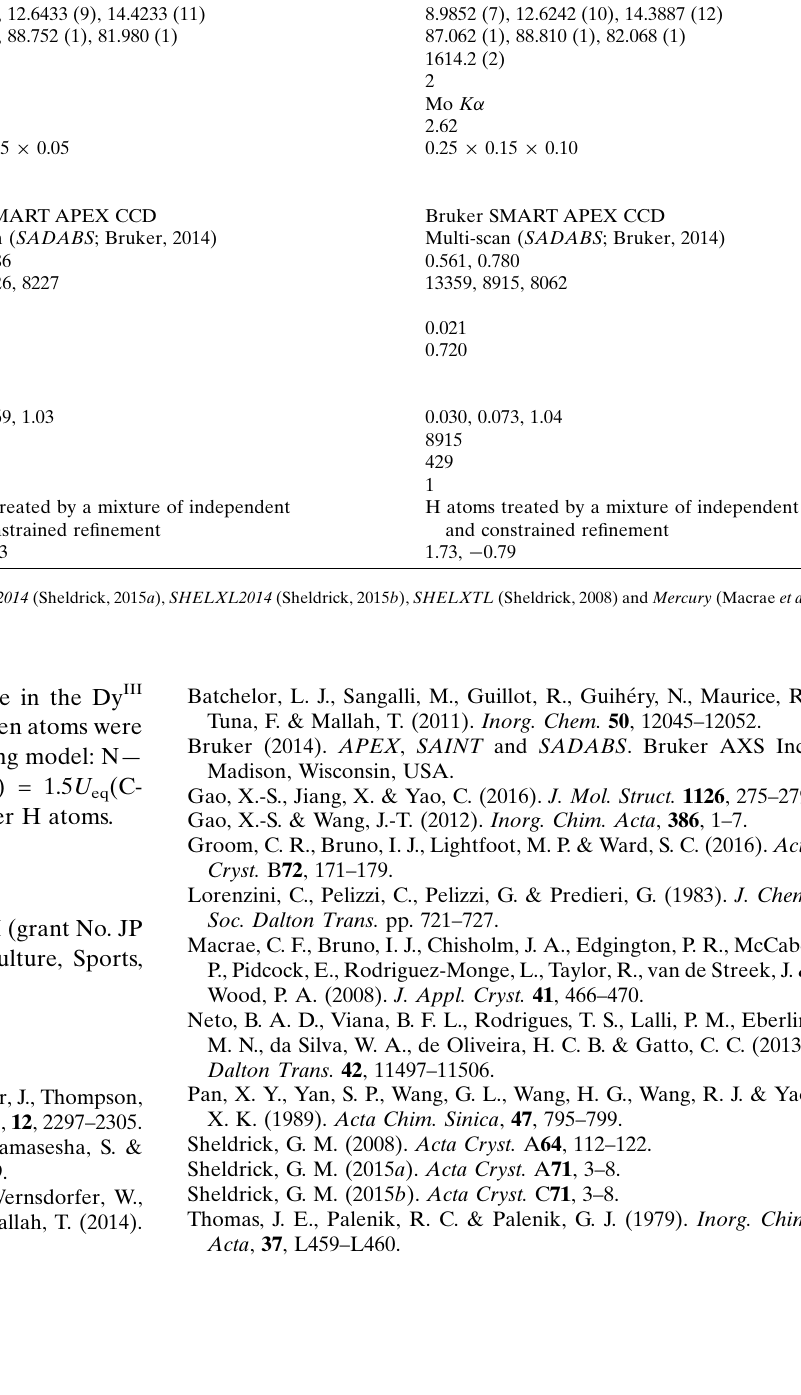
Crystal data Chemical